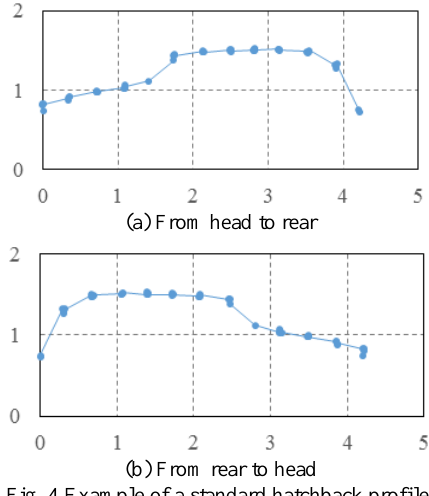
Fig. 4 Example of a standard hatchback profile. Algorithm 2: Vehicle recognition using dynamic time